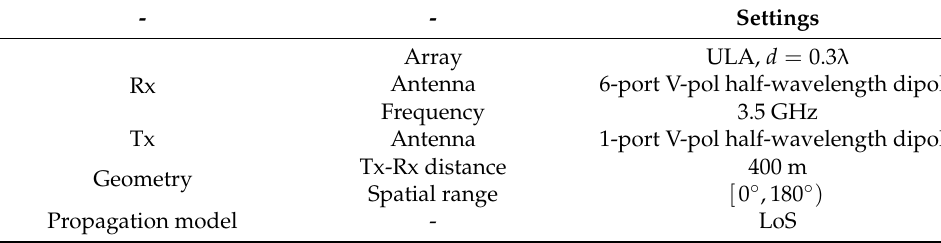
Table 3 lists the parameters of system setting. Table 3. System